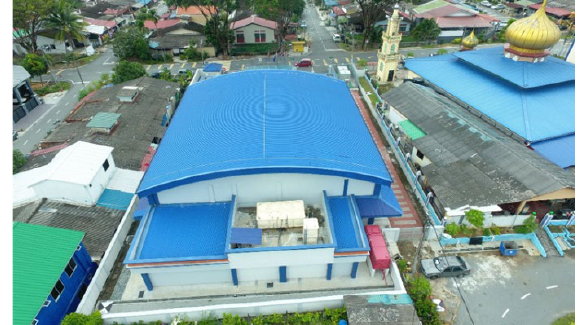
Figure 9. Rooftop area covered by UAV